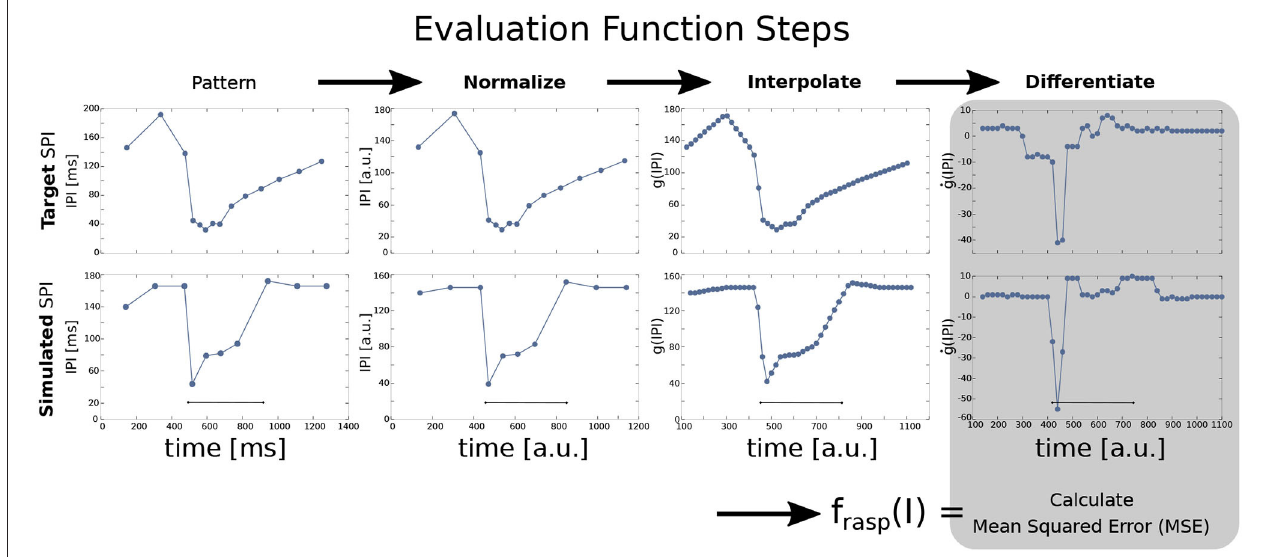
FIGURE 3 | Steps for SPI output fitness evaluation in a rasp pattern example comparing a target SPI (top) and a simulated SPI (bottom). The input current step function is injected at 500 ms and lasts for 400 ms. First, the SPI is normalized to 1,000 arbitrary units (in the figure, it is represented starting at the first IPI). Normalized IPIs are then interpolated every 20 ms and differentiated ( ˙ g ( IPI )). Finally, the mean squared error (MSE) is calculated between the target SPI pattern and the simulated one to get the fitting value for one specific pattern (Equation 7). The fitness value of the overall model is the sum of the fitness results for each pattern (refer to Equation